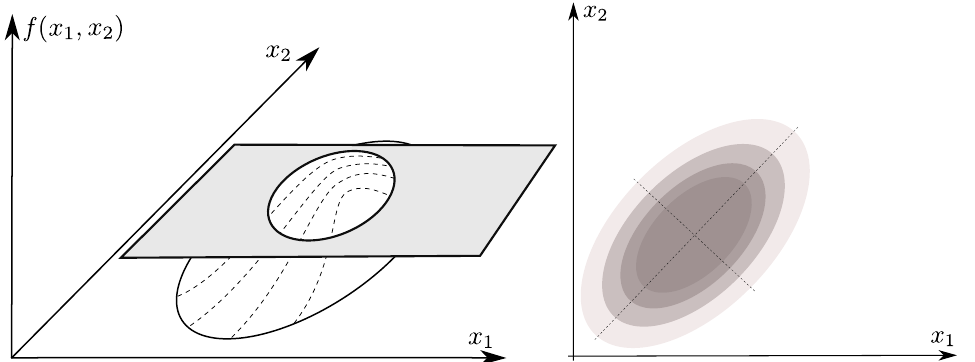
Figure 3. A schematic of a bivariate normal distribution ( left ) [33] and elliptic cross-section of this distribution ( right ). Projecting the cross-sectional area on the ( x 1 , x 2 ) plane results in an ellipsoid.